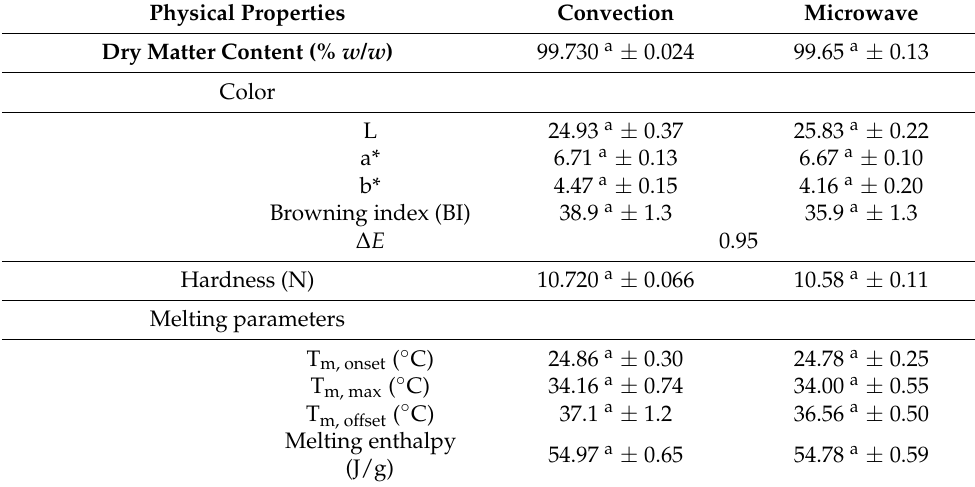
Table 2. Dry matter content, color (L, a*, b*, BI, ∆ E), hardness, and melting (Tm onset, max, offset, and melting enthalpy) parameters measured for chocolate produced from convectively and microwave roasted beans.